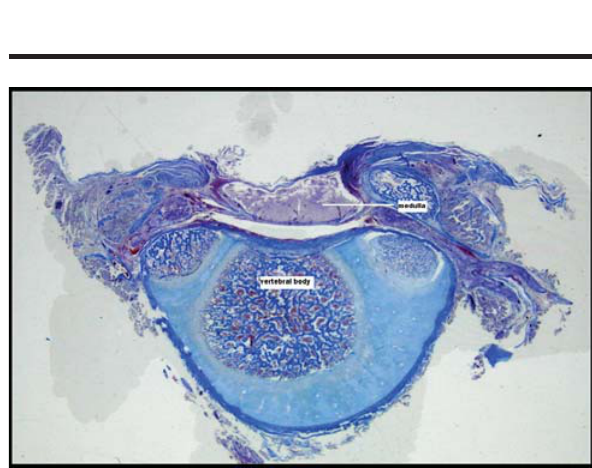
FIGURA 4 - Postmorten magnetic ressonance immaging of fetal brain in logitudinal view. (A) Note the cerebellar (arrow) herniation into the spinal canal, Arnold-Chiari malformation. (B) Normal position of the cerebelum,